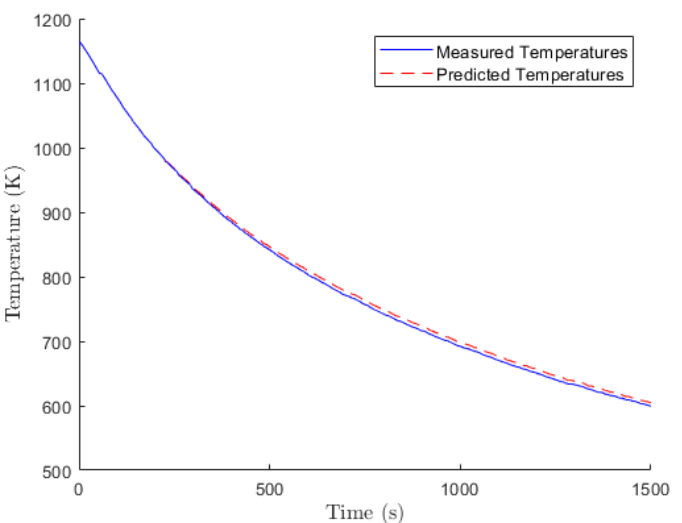
Figure 5. Comparison of measured temperatures and predicted temperatures for an unknown alumina rod.